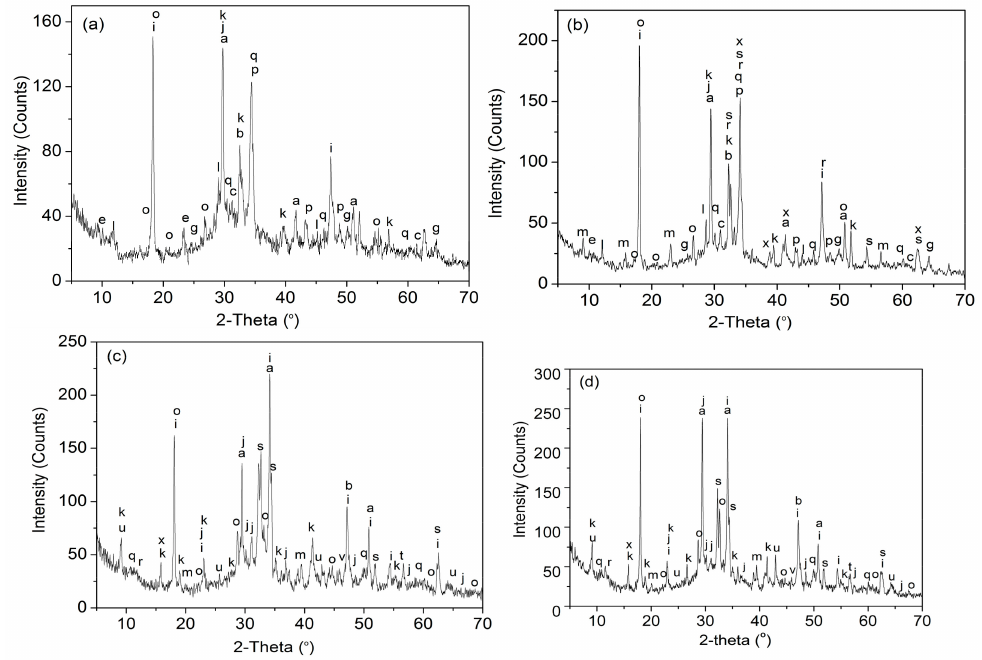
Figure 6. X-Ray Diffraction (XRD) patterns of cement composites at 28 days: ( a ) S 1 ; ( b ) S 2 ; ( c ) S 3 ; ( d ) S 4 . Table 4. Crystal phases of cement